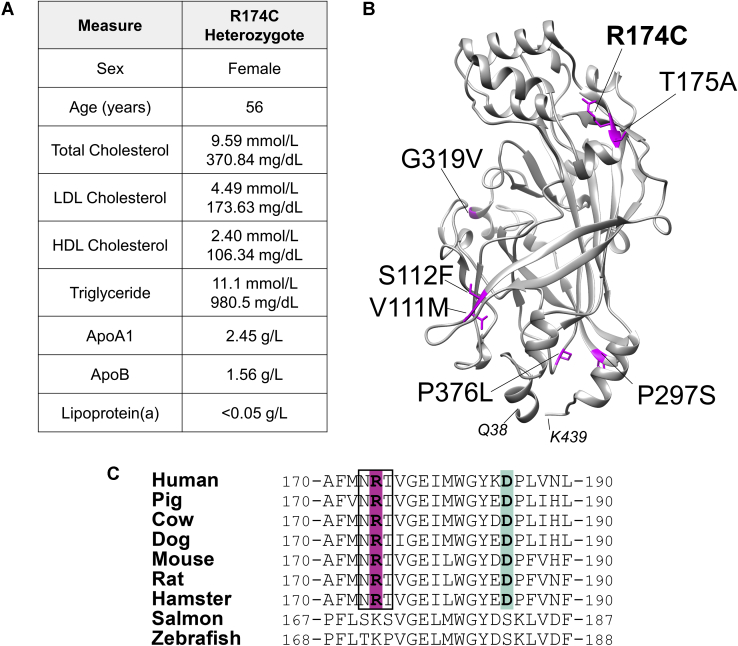
R174C-SR-BI is a rare human variant of SR-BI identified in an individual with high HDL-cholesterol. A: Characteristics and lipid profile of the R174C-SR-BI heterozygous individual. B: A homology model of the extracellular domain of human SR-BI (residues 38–439) was generated using Modeller software, and residues that correspond to sites of known human variants are colored in pink. C: Multiple species sequence alignments of SR-BI were generated by the MUltiple Sequence Comparison by Log-Expectation algorithm. Arg-174 and Asp-185 (possible ion pair) are highlighted in magenta and light green, respectively, and the boxed region represents a conserved N-linked glycosylation sequence (NXT). SR-BI, scavenger receptor class B type I.